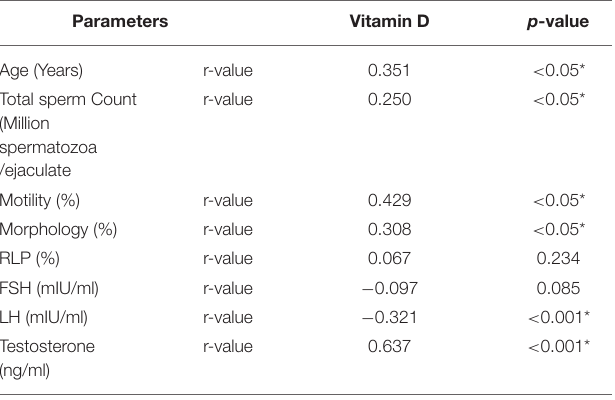
TABLE 2 | Correlation of vitamin D (25OHD) with sperm parameters and male reproductive hormones in the study cohort. Parameters Vitamin D p -value